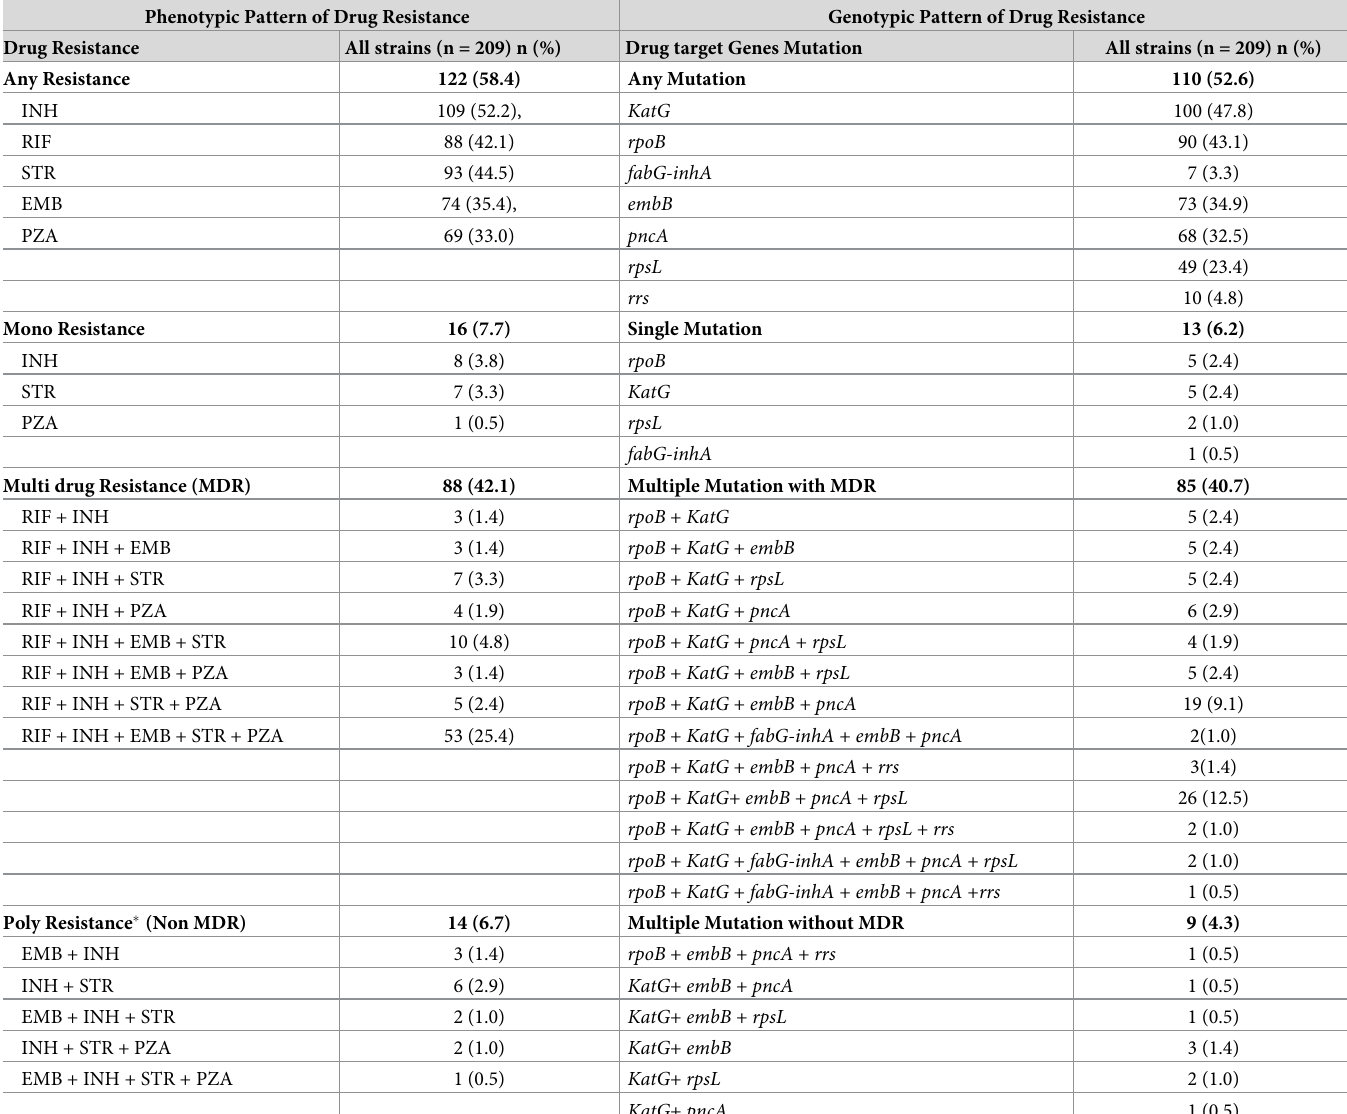
Table 3. Phenotypic and genotypic drug resistance patterns in MTBC